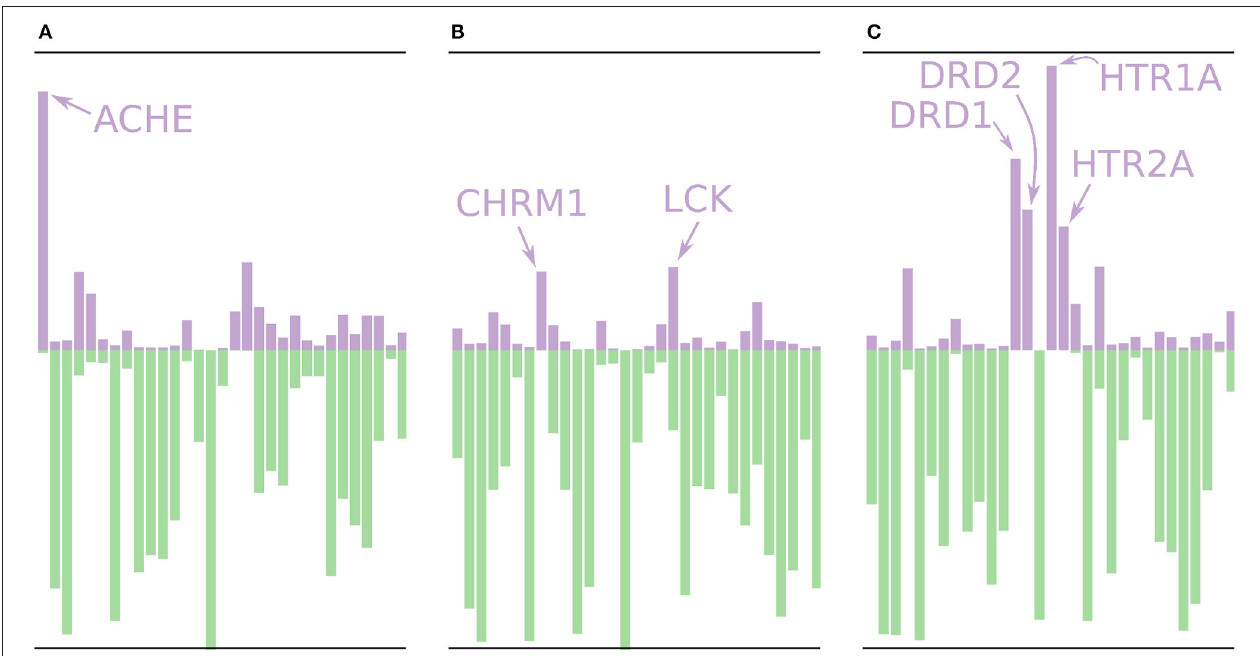
FIGURE 7 | Profiles for a few of the removed drugs using the validation models, i.e., these molecules are not in the training sets for the models. The profiles are shown as bar plots with two bars for each target: A purple bar pointing in the upward direction, indicating the size of the p -value of the “Active” label, and a green bar pointing downwards, indicating the size of the p -value for the “Non-active” label. (A) The profile for Tacrine, a centrally acting anticholinesterase, with a distinct peak for the ACHE gene. (B) The profile for Pilocarpine, a muscarinic acetylcholine receptor M 1 agonist, with only two moderately higher peaks for active prediction, CHRM1 and LCK. (C) The profile for Pergolide, a DRD1, DRD2, HTR1A, and HTR2A agonist, which is reflected by the four highest p -values for an active